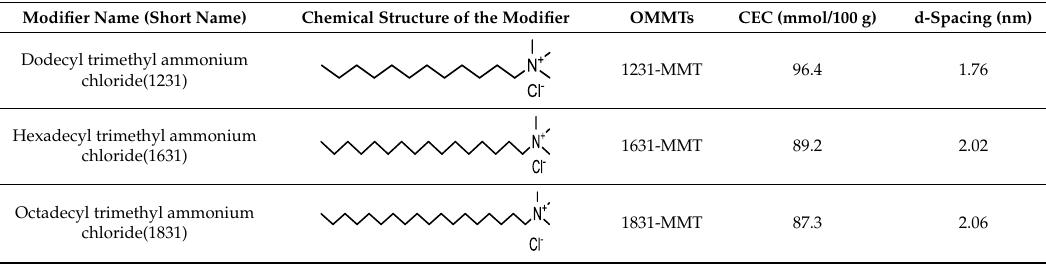
Table 1. Characteristics of the three quaternary ammonium salts and organic montmorillonites